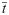
Relationship between zreach and tstay of molecules in −3.0 < zreach < 3.0.(a) Dataset representing relationship between zreach and tstay of molecules; (b) dataset in zreach–t¯ coordinate plane. Bins with dc × dc are set to calculate the values of the bivariate histogram. (c) Bivariate histogram of data points in zreach–t¯ coordinate plane.